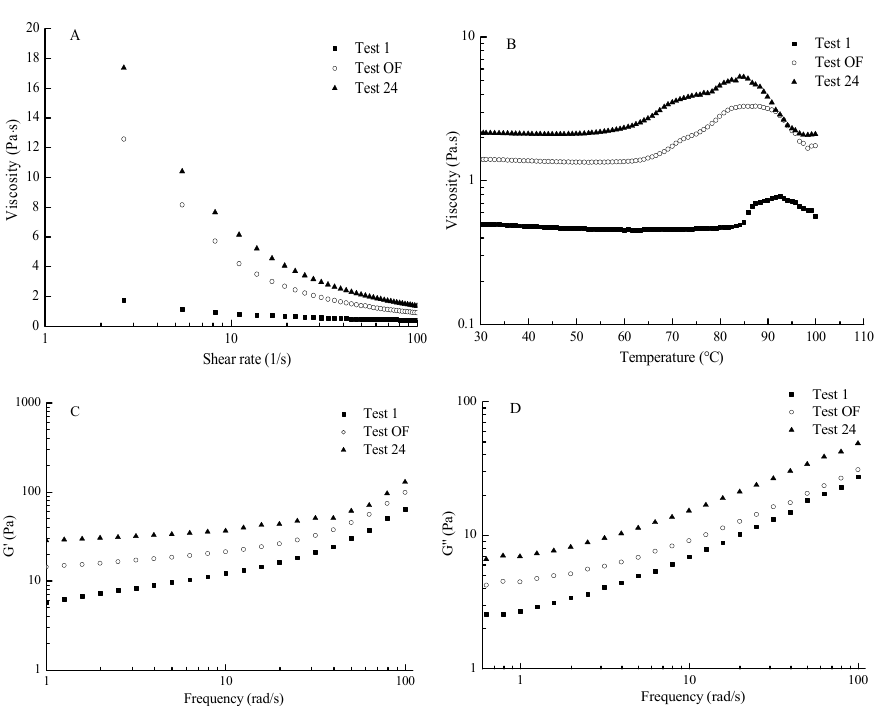
Figure 6. Rheological behaviors. ( A ) Apparent viscosity, ( B ) effect of temperature on viscosity, ( C ) G ′, and ( D ) G″) of the different printing systems (Test OF, Tests 1 and 24 at the viscosity of 1.374, 0.483, and 2.058 Pa·s).